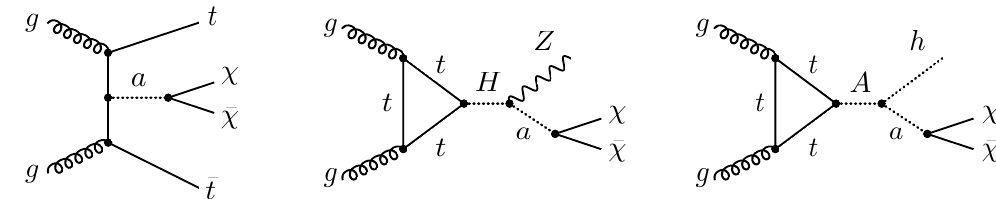
Figure 1 . Assorted diagrams that give rise to a t (cid:22) t + E T; miss (left), Z + E T; miss (middle) and h + E T; miss (right) signal in the simpli(cid:12)ed pseudoscalar model considered in our work. The ex- changed spin-0 particles are of scalar ( H ) or pseudoscalar ( a; A ) type. Further Feynman graphs that contribute to the di(cid:11)erent mono- X channels can be found in (cid:12)gures 7 to